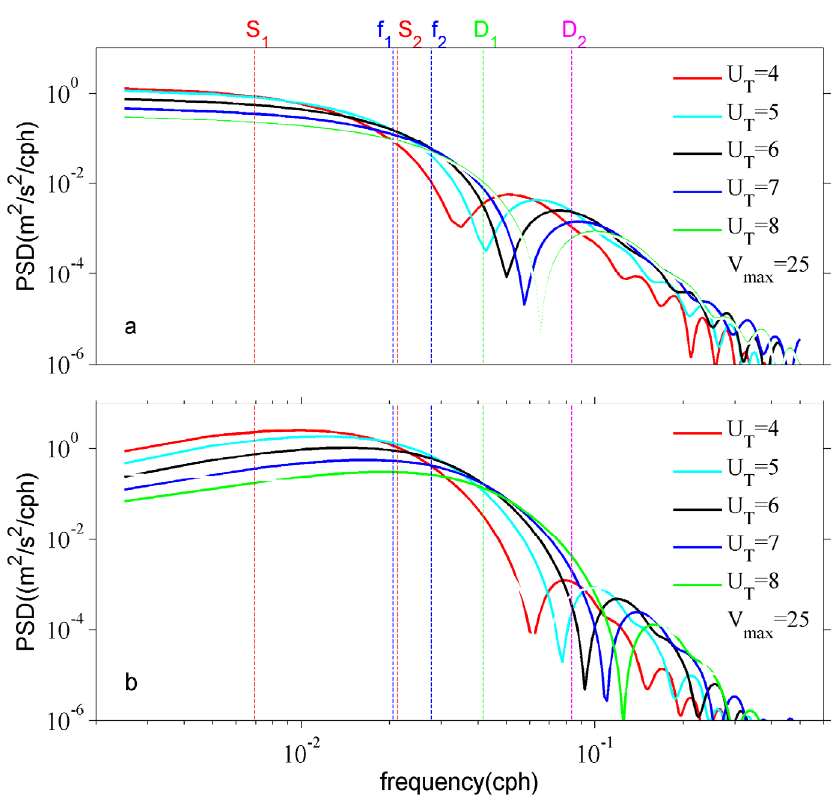
Figure 10. Power spectral densities (PSDs) of ( a ) eastward components and ( b ) northward components of wind stress at location A (solid lines). The blue dashed lines indicate the range of filtered near-inertial frequency band (f 1 –f 2 ). The red dashed lines indicate the range of synoptic frequency band (S 1 –S 2 ). The green and magenta dashed lines denote the diurnal (D 1 ) and semidiurnal (D 2 ) frequencies, respectively.